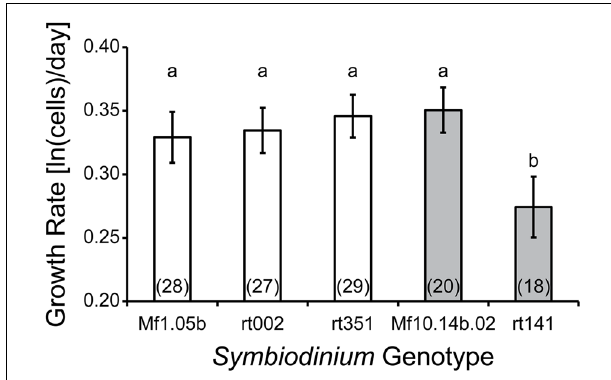
FIGURE 3 | Symbiodinium culture growth as a function of genotype. S. minutum genotypes (white bars) showed little variation in growth rates compared to S. psygmophilum genotypes (gray bars). Letters indicate statistically different growth rate groupings (Tukey’s HSD; p < 0.05). Numbers in parentheses indicate sample size (number of wells). Error bars depict 95% confidence intervals. Denecke etal. (unpublished